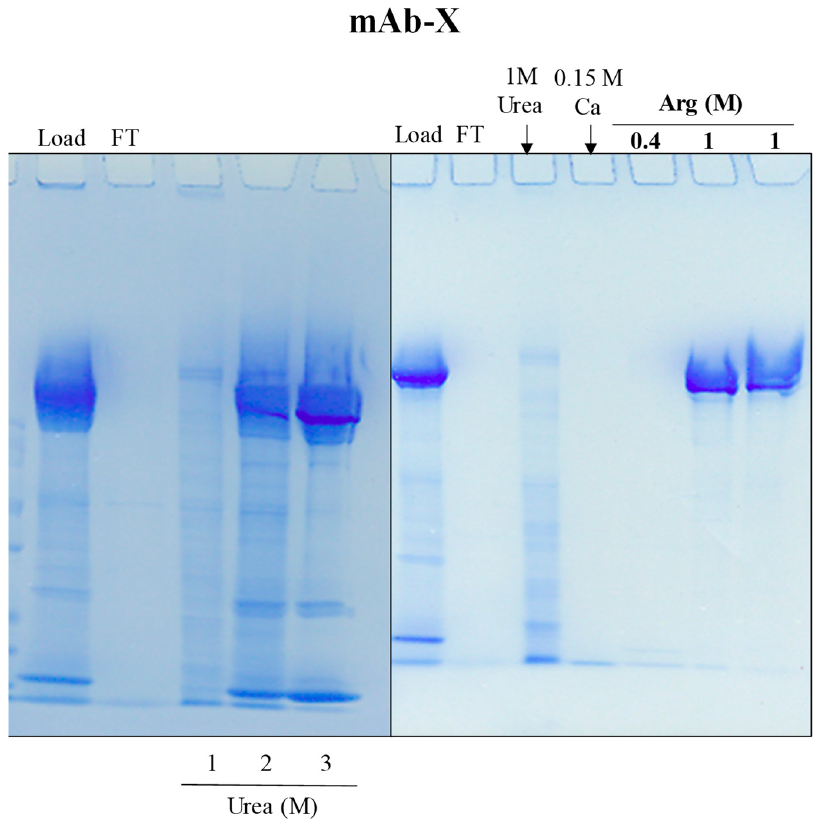
Figure 7. MEP chromatography of mAb-X. The bound mAb-X was eluted with 1, 2 and 3 M urea at pH 7.0. Purification of mAb-X from cell culture media was conducted with washes using 1 M urea, 0.15 M CaCl 2 and 0.4 M arginine followed by elution with 1 M arginine twice, all at pH 7.0.